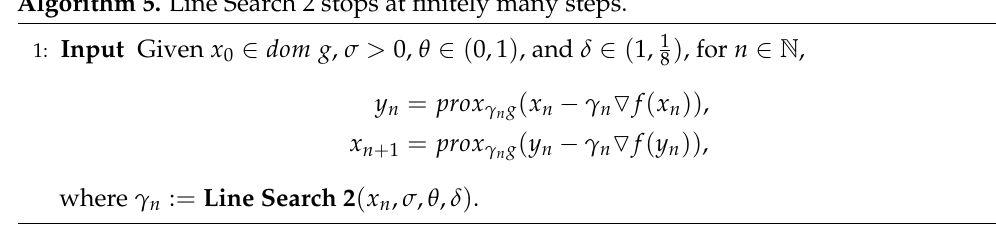
Algorithm 5. Line Search 2 stops at finitely many